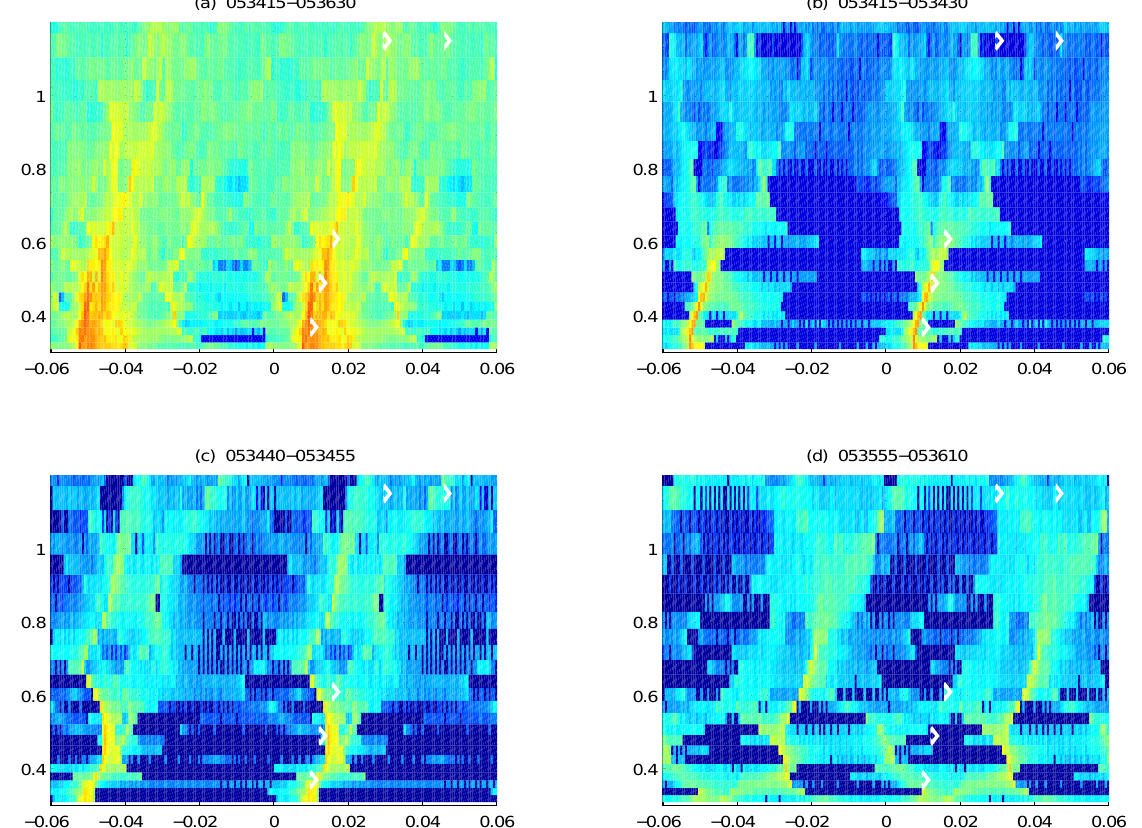
Fig. 6. A set of snapshots of the ω − k dispersion. Panel (a) is calculated using data covering the period 05:34:15–05:36:30 UT. The other snapshots are computed using 15-s worth of data, beginning at different times within the period under study. In all cases data from satellites 3 and 4 were used. Superimposed onto each plot are the projections of the wave vectors determined using the k-filtering method along the satellite separation vectors. The white diamonds superimposed onto each plot are the projections of the wave vectors associated with mirror modes determined using the k-filtering